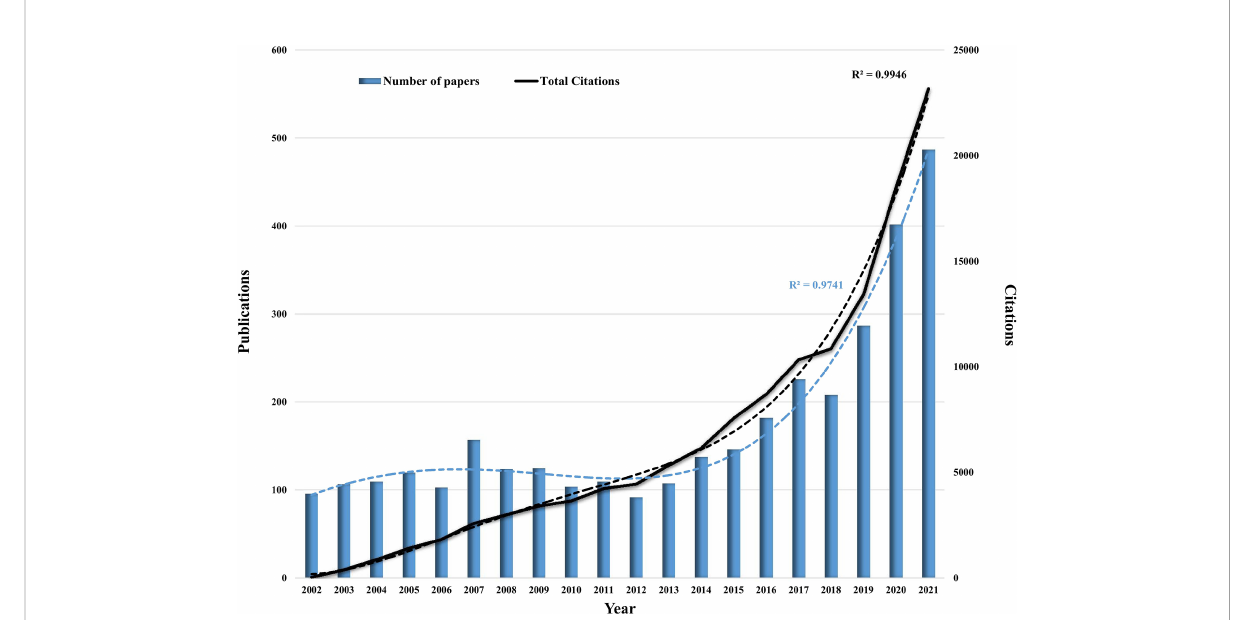
FIGURE 2 Global trend of publications and total citations on RCC immunotherapy from 2002 to 2021. The blue and black dotted lines represent the trend- fi tted curves using polynomial regression model. The correlation coef fi cients (R 2 ) are displayed in the fi